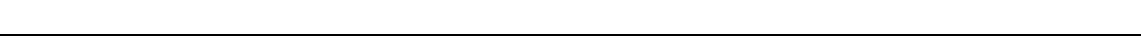
Fig. 3 Paneth cells do not express CSF1R mRNA and protein. Mice were treated with anti-CSF1R mAb or control-IgG (control) for 6 weeks before analysis. A parallel group of mice were allowed to recover for 8 wk following anti-CSF1R mAb treatment. a Analysis of H&E stained intestines revealed that Paneth cells containing secretory granules (arrows) were present following prolonged CSF1R blockade. Scale bar, 20 µ m. Representative images from 3 mice/ group are shown. b RNA in situ hybridization analyses showed that Defa1 mRNA (red) was abundantly expressed in the intestinal crypts of mice treated with anti-CSF1R mAb. Scale bar, 100 µ m. Representative images from 3 mice/group are shown. c Morphometric analysis of the % crypts with Defa1 - expressing Paneth cells in the crypts of mice from each treatment group. Data represent mean ± SD derived from 3 mice/group, and 96 – 100 crypts/ section. ns, not signi fi cant, one-way ANOVA with Tukey ’ s post hoc test. d IHC analysis of the crypts of untreated Csf1r -EGFP mice shows Paneth cells do not express CSF1R. In the crypt EGFP expression was only detected in cells with a macrophage morphology. e RT – qPCR analysis shows negligible expression of Cd68 , Emr1 , and Csf1r in mRNA from isolated intestinal crypts. Data are normalized to the expression of Gapdh . f RNA in situ hybridization analyses showed that Csf1r mRNA (blue) was not expressed in the epithelium of the small intestine. Scale bar, 50 µ m. Inset shows absence of Csf1r mRNA in the epithelium of the intestinal crypt. g IHC analysis of lysozyme-expressing Paneth cells (red) in intestinal crypts and CD68 + macrophages (green) in the gut wall of Csf1r Δ IEC , Vil1-Cre and Csf1r FL/FL mice. Representative images from three mice/group are shown. Scale bar 100 µ m. h